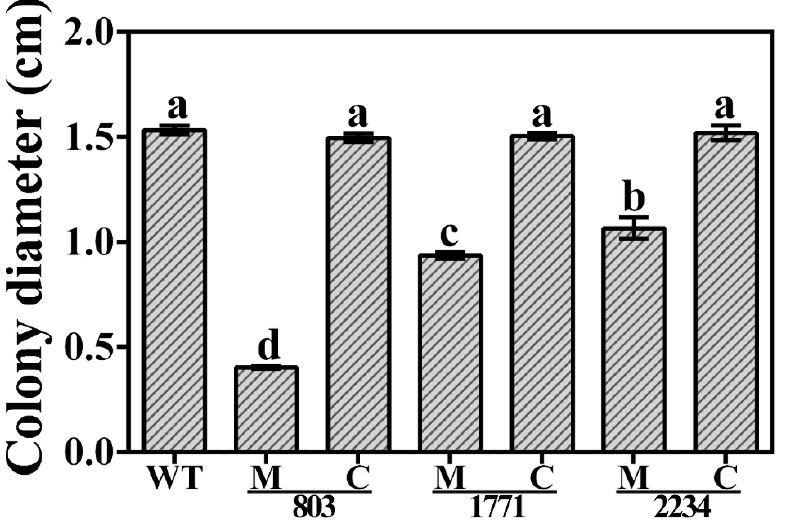
Figure 9. Motility of the three knockout mutants and corresponding complemented strains of Xanthomonas oryzae pv. oryzae strain C2. WT: Wild type; M: Knockout mutant; C: Complemented strains. Colony diameter (cm) was presented as means standard errors ( n = 3). Columns with different letters (a–d) are significantly different according to LSD test ( p = 0.05).